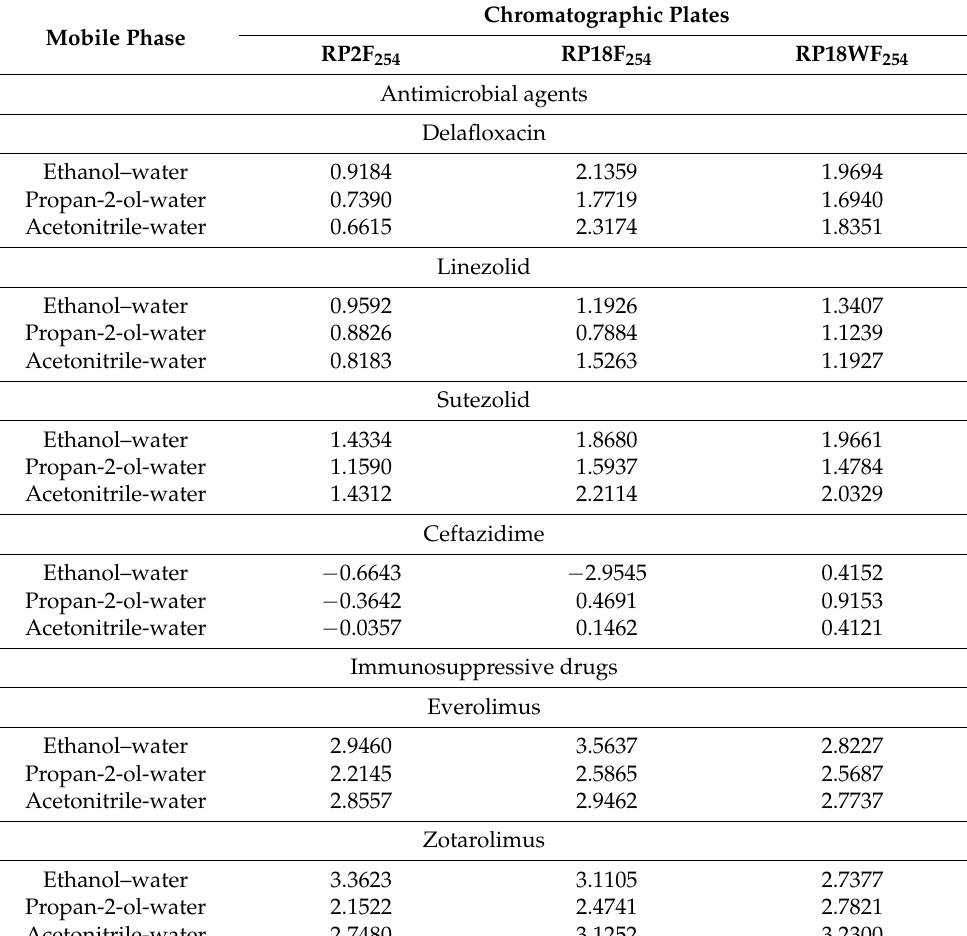
Table 3. Comparison of R MW values of tested compounds obtained by using TLC